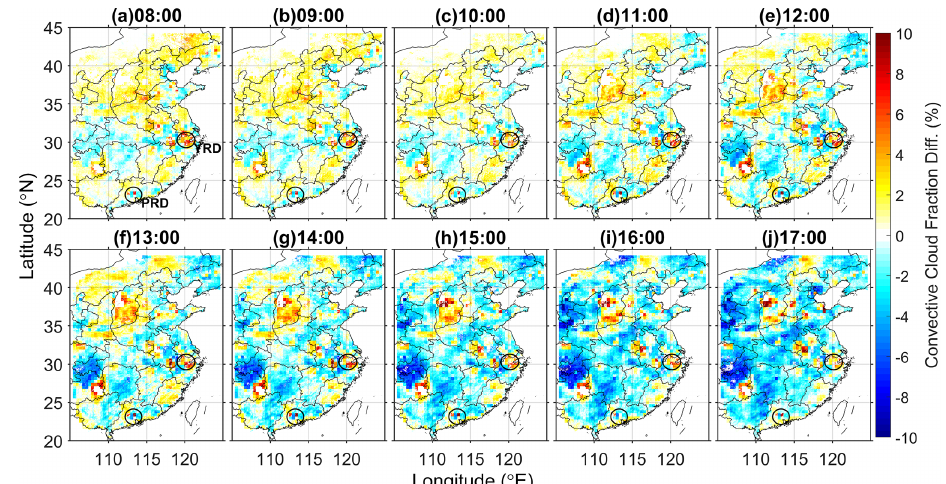
Figure 7. Diurnal changes of convective cloud fraction (CCF) difference between polluted and clean conditions (polluted − clean) during May–September in 2016/17. Time marked above each figure is the local time. Black circles mark the Yangtze River Delta (YRD) and Pearl River Delta (PRD). (Note that grid points are plotted only if they exceed the 95% significance level ( p < 0.05) according to the Pearson χ 2 test.)